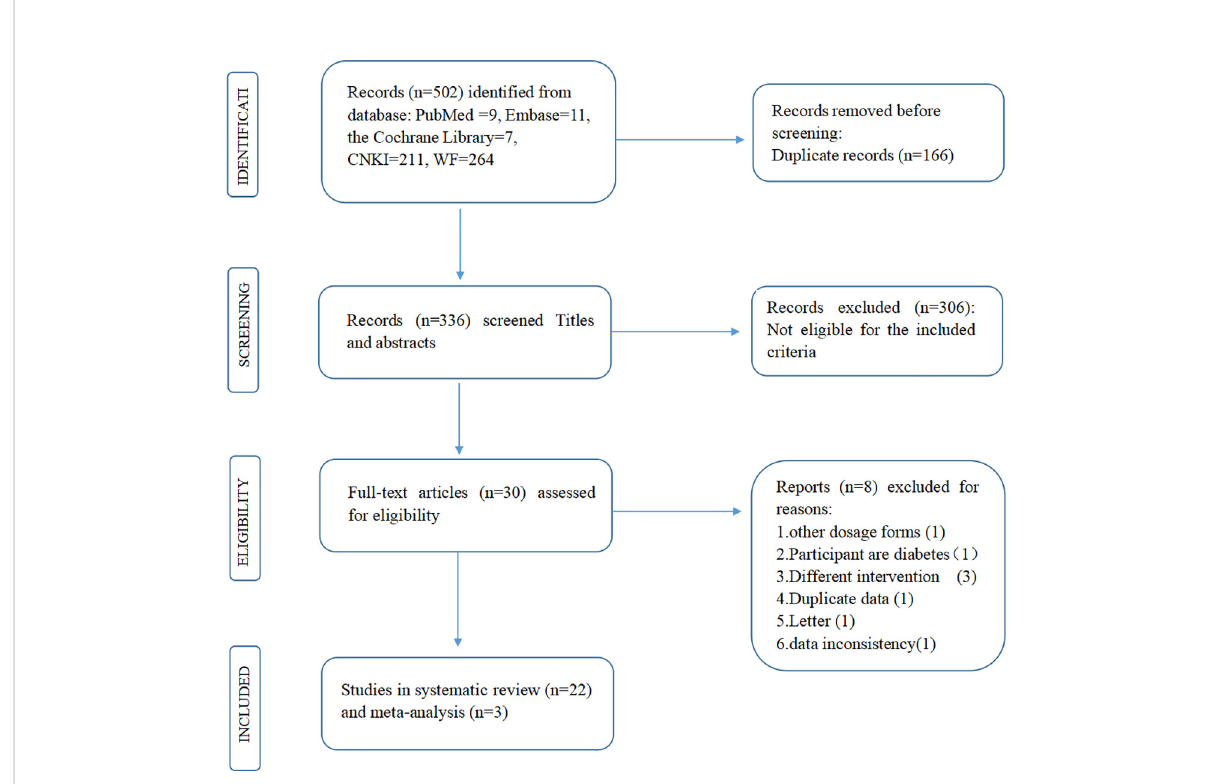
FIGURE 1 Flowchart of the study ’ s selection